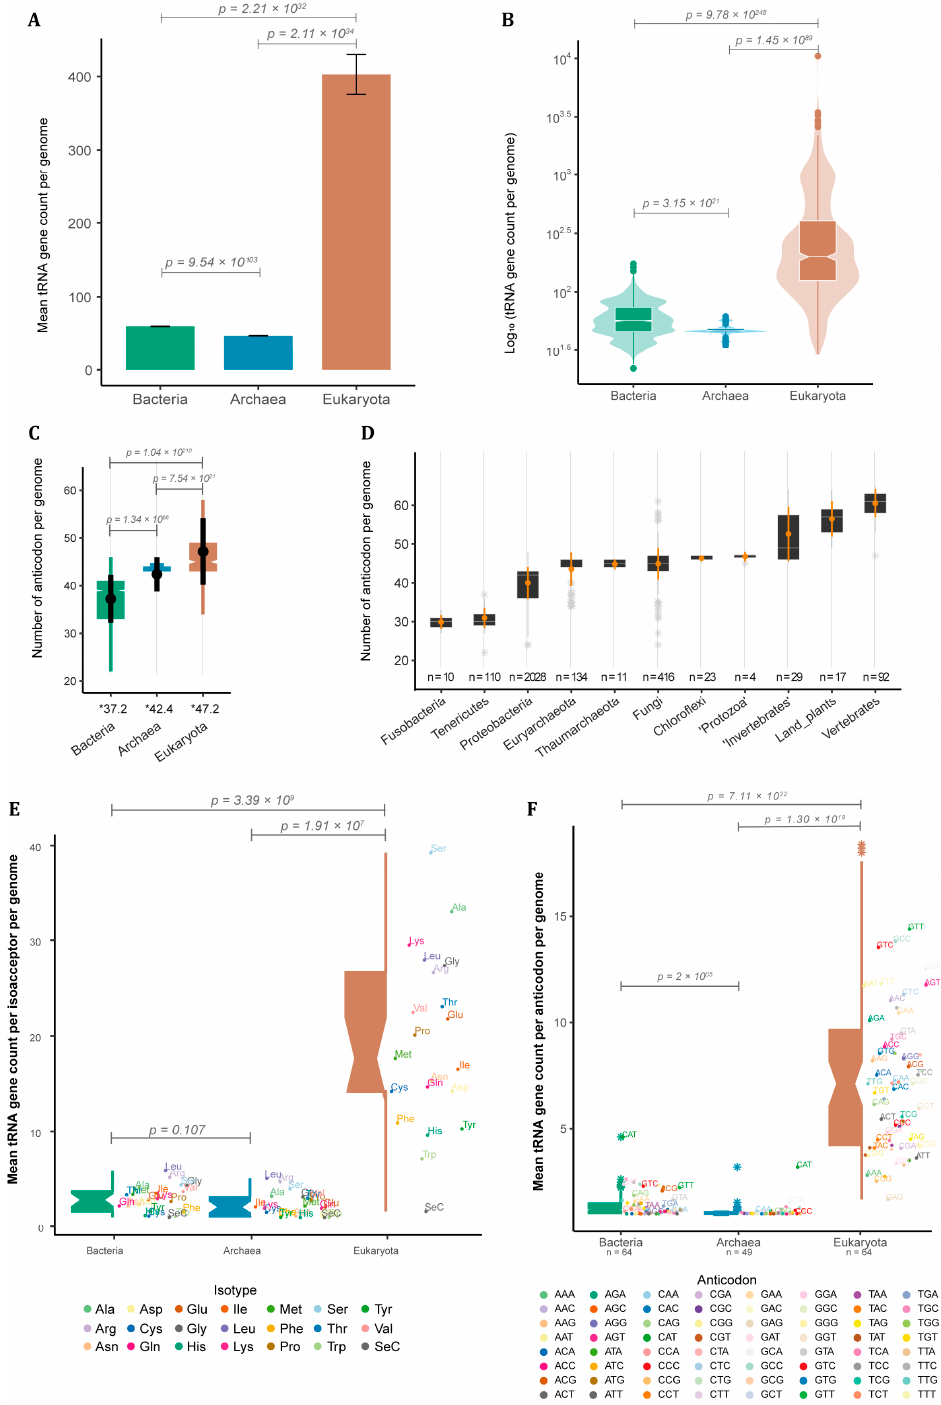
Figure 1. tRNA gene count across the three domains of life. ( A ) Mean tRNA gene count per genome with standard error (SE) and ( B ) distribution of tRNA gene count per genome in bacteria ( n = 4027), archaea ( n = 217) and eukarya ( n = 559). ( C ) Distribution of the number of tRNA isoacceptors (different anticodons) per genome per domain, with mean and standard deviation (SD) in black (* = mean of anticodon per genome per domain). ( D ) Distribution of tRNA isoacceptor count of selected taxa, with mean and SD in orange ( n = number of genomes per taxa). ( E ) Number of tRNA genes per amino acid and ( F ) anticodon per genome per domain ( n = number of different anticodons). p -values are shown for all contrasts (see methods for statistical